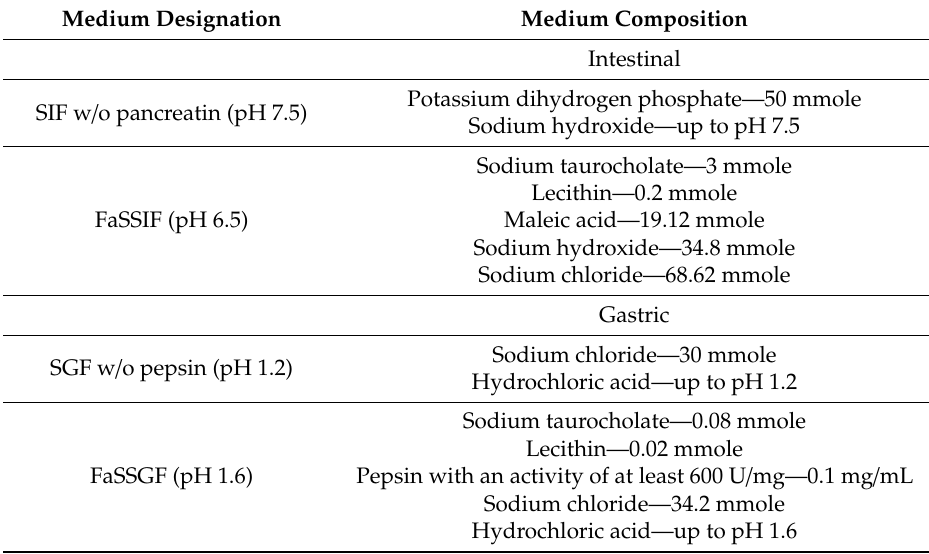
Table 4. Model bio-relevant